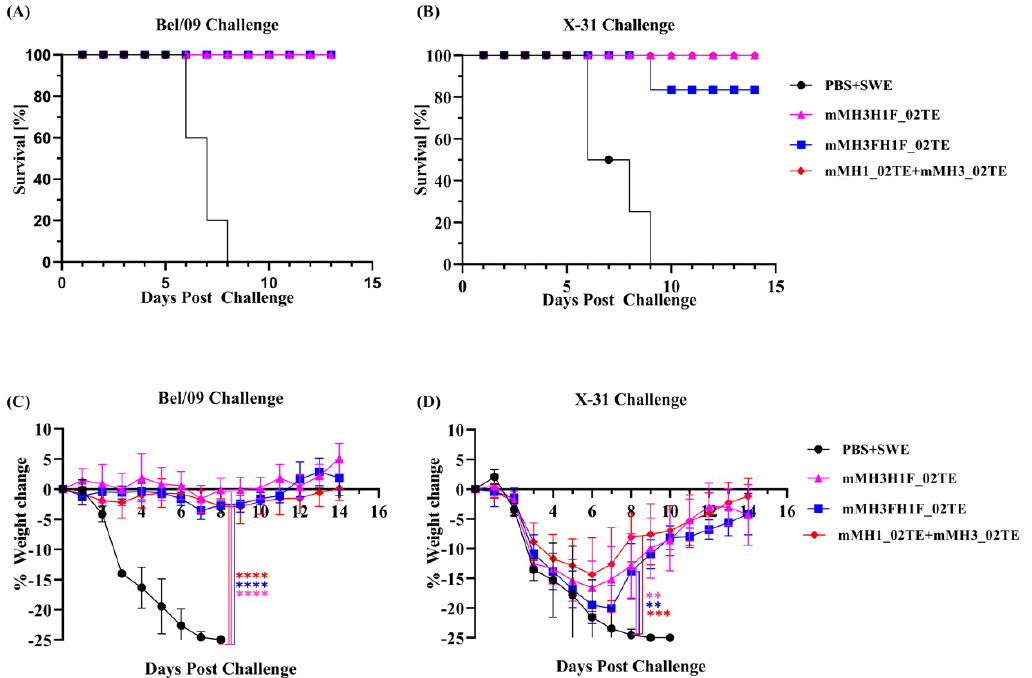
Figure 7. Hemagglutinin ectofusion immunogens protect mice against challenge. Mice ( n = 5/group) were primed (day 0) and boosted (day 21) with 20 µ g of the indicated immunogens and challenged intranasally 21 days after the boost with 10 MLD 50 of mouse-adapted Bel/09 and X − 31 viruses. ( A , B ) survival and ( C , D ) percentage weight change was monitored for 14 days post − challenge. Adjuvant-treated mice were used as controls. In contrast to unimmunized mice controls, mMH3H1F_02TE and mMH1FH3F_02TE conferred protection, similar to that of the mMH3_02TE + mMH1_02TE mixture. Multiple Student’s t − test was performed with Bonferroni Dunn’s correction method for pairwise weight change comparisons (** indicates p < 0.01, *** indicates p < 0.001 and **** indicates p < 0.0001).